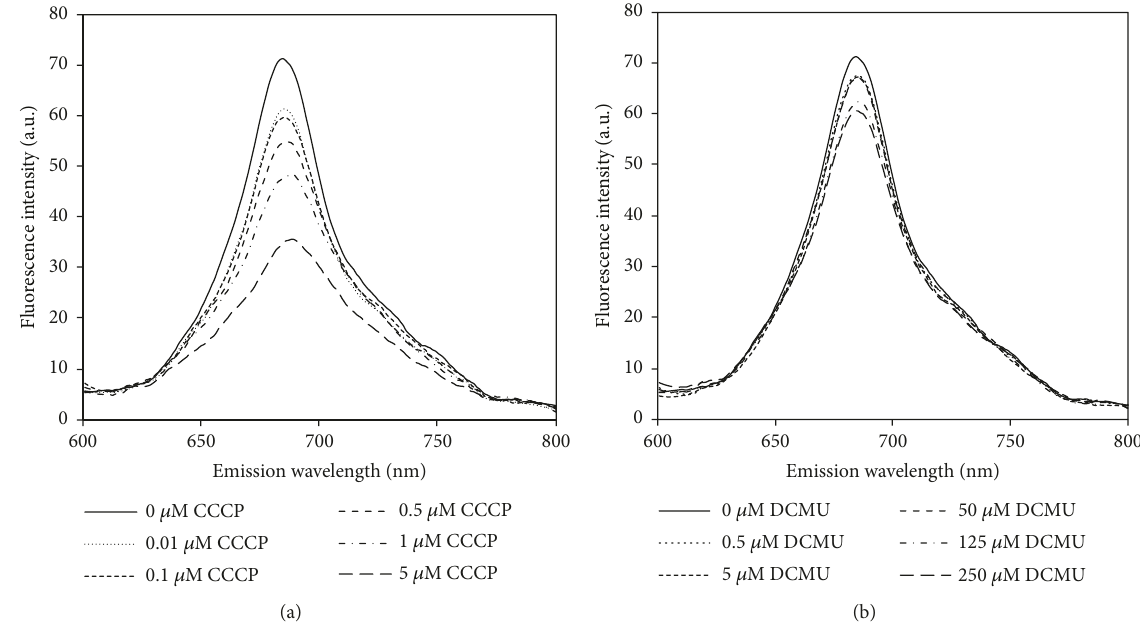
Figure 4: Fluorescence emission spectra of Aphanothece halophytica incubated in BG11 0 (pH 7.4) supplemented with Turk Island salt solution containing various concentrations of carbonyl cyanide m-chlorophenyl hydrazone (CCCP) (a) and 3-(3,4-dichlorophenyl)-1,1-dimethylurea (DCMU) (b) after 2 hours of treatment under